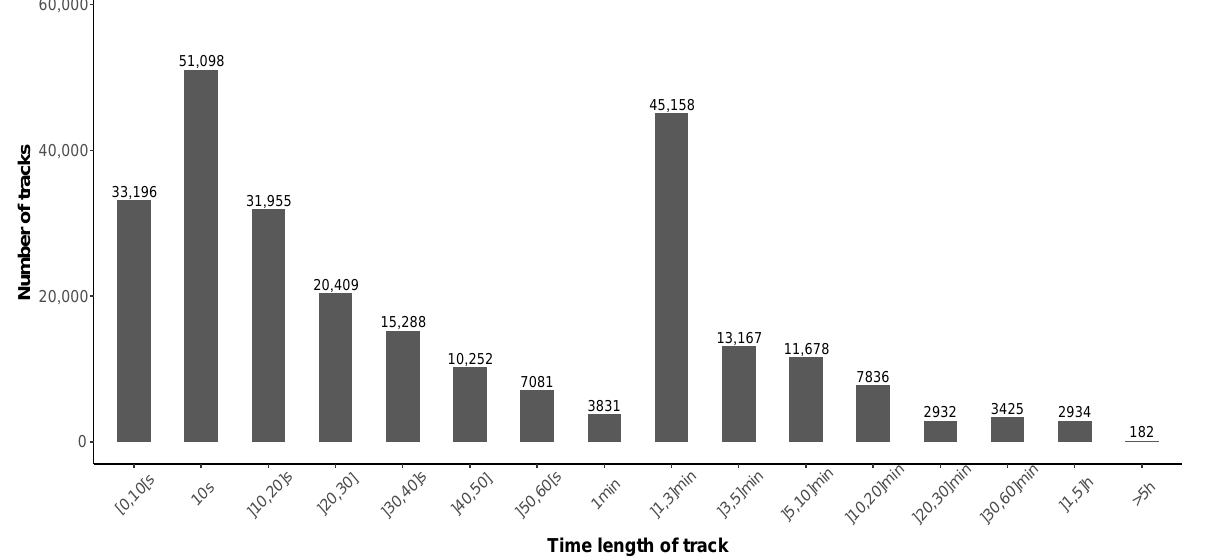
Figure 11. Distribution of tracks in function of the duration of the measurement ( ‘time_length’